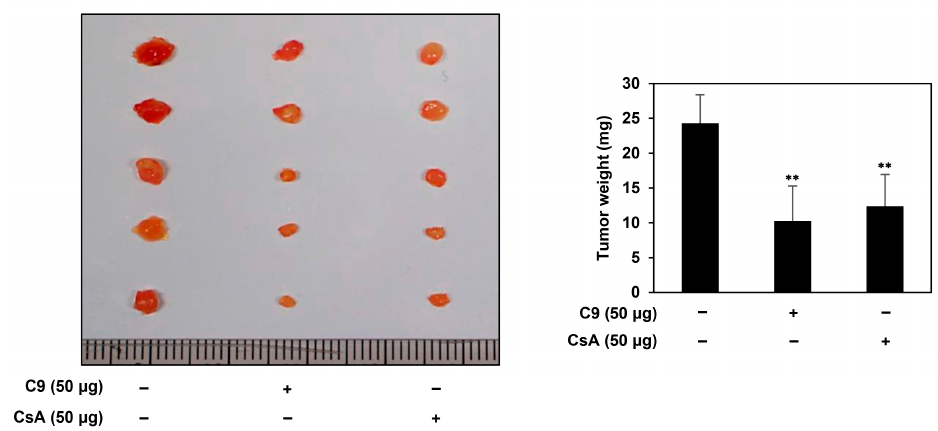
Figure 4. Effects of C9 and CsA on tumor growth derived by MKN45 GCSCs in a CAM model. MKN45-derived GCSCs were mixed with Matrigel in the absence or presence of the compounds (50 μ g/egg) and placed onto the CAM surface of fertilized chick eggs. After incubation for seven days, the CAMs were observed, the formed tumors were retrieved, and the tumors’ weights were calculated. ** p < 0.005 vs. the control.